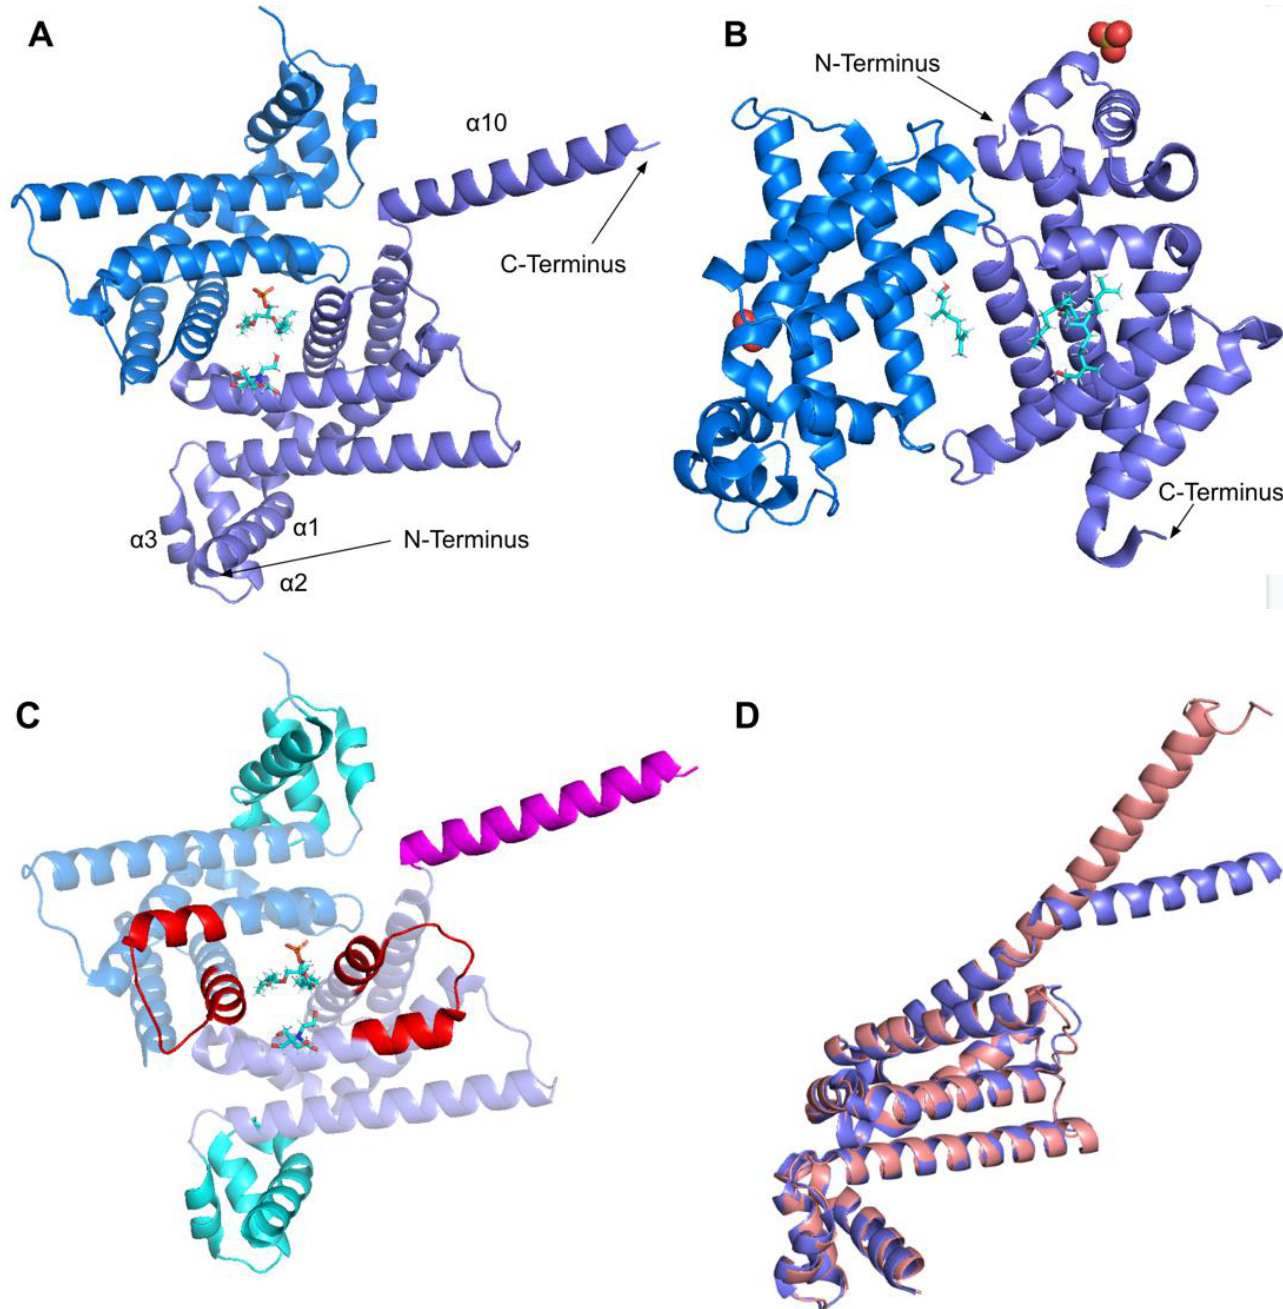
Figure 29. Comparison of existing structures of COQ9 and the AlphaFold model of COQ9 ( A ) PDB: 6AWL structure of COQ9 ΔN79 with co-crystallized phosphatidylethanolamine and bis-tris shown in cyan, data from [50]. Chain A colored in purple, chain B colored in blue. ( B ) PDB: 6DEW structure of COQ9 ΔN79,ΔC36 with co-crystallized geraniol, cis-trans-farnesol, trans-trans-farnesol, and cis-cis- farnesol shown in cyan and sulfate molecules shown as ball structures; Chain A colored in purple, chain B colored in blue, data from [50]. ( C ) Structural motifs shown on 6AWL structure. Colors match Figure 28. ( D ) Structural alignment of 6AWL chain A shown in purple with the AlphaFold model obtained from the AlphaFold Protein Structure Database [39,54], shown in pink. This indicates COQ9 as lipid-binding and its hydrophobic pocket as a potential bind- ing site. Structural motifs noted in Figure 28 are designated on the 6AWL structure (Figure 29C). A model for human COQ9 was obtained using the AlphaFold Protein Structure